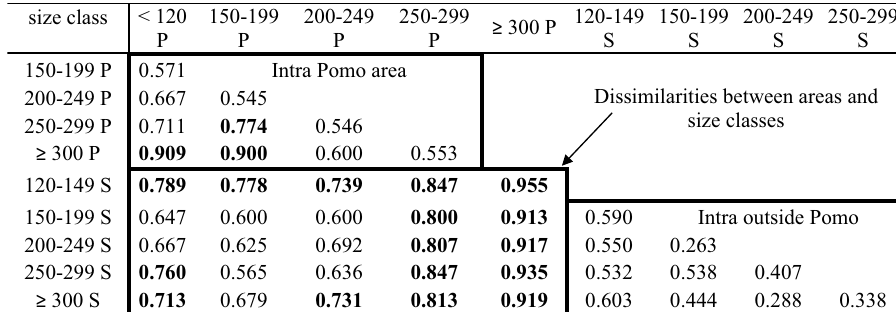
Table 2. Inter-size class variability measured as Bray–Curtis dissimilarities calculated using occurrence-based data for individuals sampled in Pomo Pit area (P) and outside (S). Values > 0.7 are bold faced. Frames highlight intra area dissimilarities (both for Pomo Pit and outside) and between areas